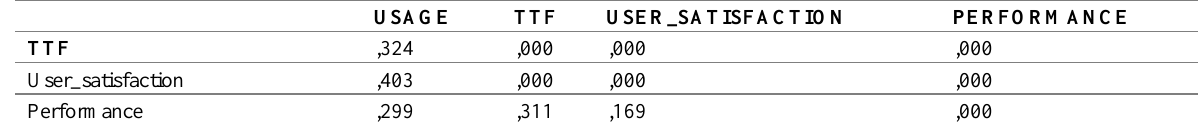
Table 3: Standardized Direct Effect